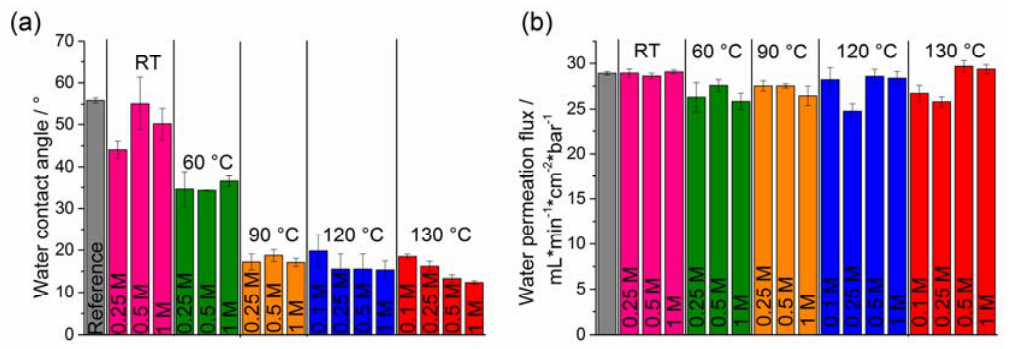
Figure 4. Water contact angle ( a ) and water permeation flux ( b ) of the unmodified membrane (Reference) and membranes with TiO 2 nanoparticles generated at different temperatures and acid concentrations.